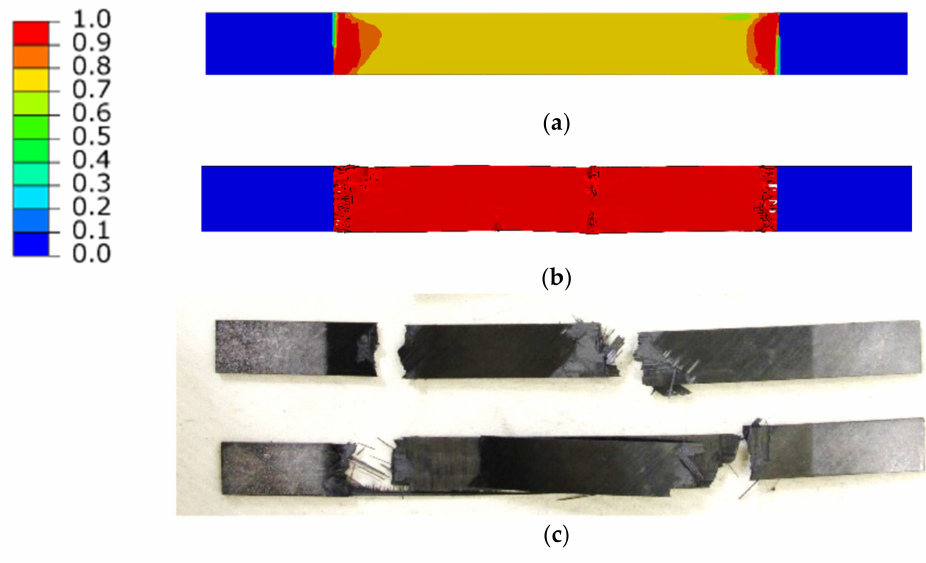
Figure 11. Damage level of the specimen; Crack initiation from the FE model ( a ), Final damage from the FE model ( b ), Damage from the experiment ( c